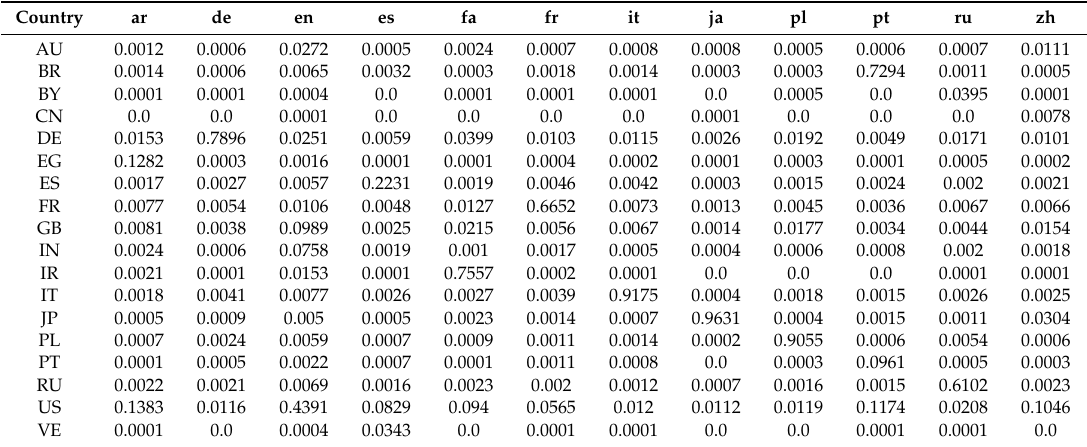
Table 9. Ratio of visits of users from selected countries to all visits of the certain Wikipedia language